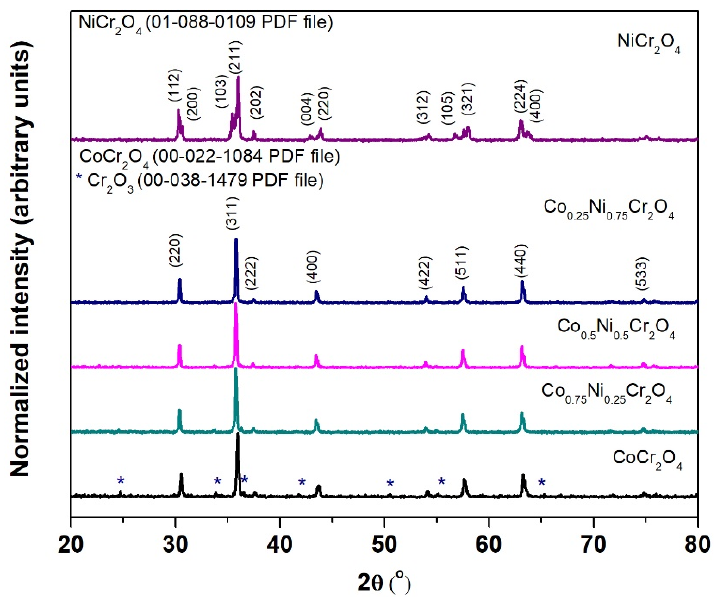
Figure 2. XRD patterns for Co (1 − x) Ni x Cr 2 O 4 pigments annealed at 1000 °C in air. The Co (1 − x) Ni x Cr 2 O 4 spinel (when x (cid:54) = 1) crystallizes in Face-Centered Cubic Both NiCr 2 O 4 and CoCr 2 O 4 oxides crystallize into normal spinel structures in the AB 2 O 4 form with Co 2+ and Ni 2+ ions occupying the tetrahedral A sites and Cr 3+ ions occu- pying octahedral B sites.